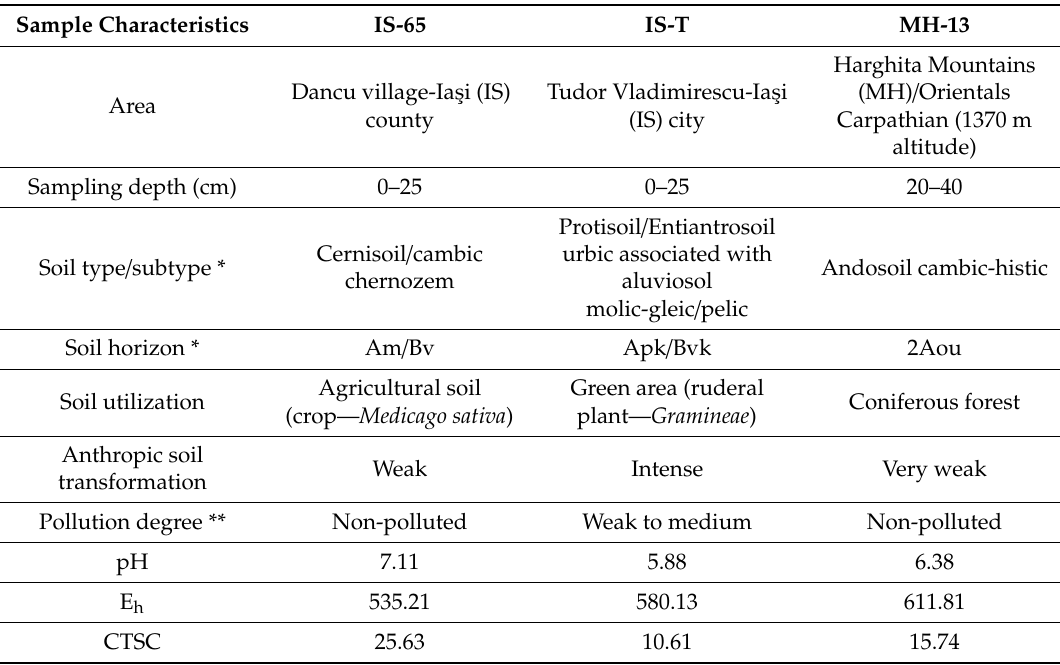
Table 1. Characteristics of soil samples